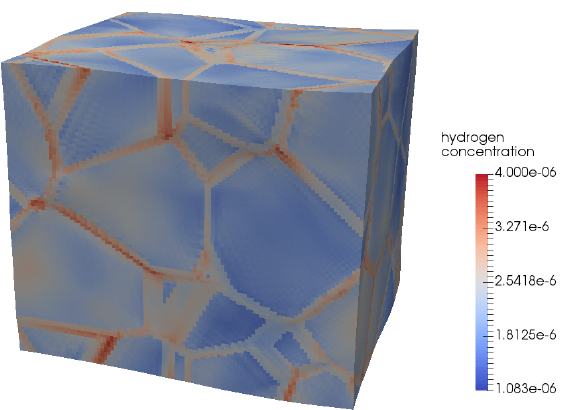
Figure 8. Simulation of a polycrystal containing dislocations with a binding energy to grain boundaries and a voxel size of L voxel = 100 µ